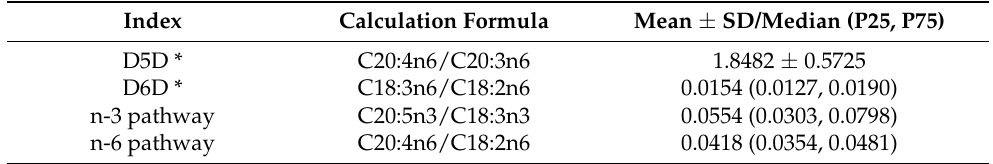
Table 5 . Indexes of PUFA with breast milk in this study. Table 5. Indexes of PUFA with breast milk in this study.